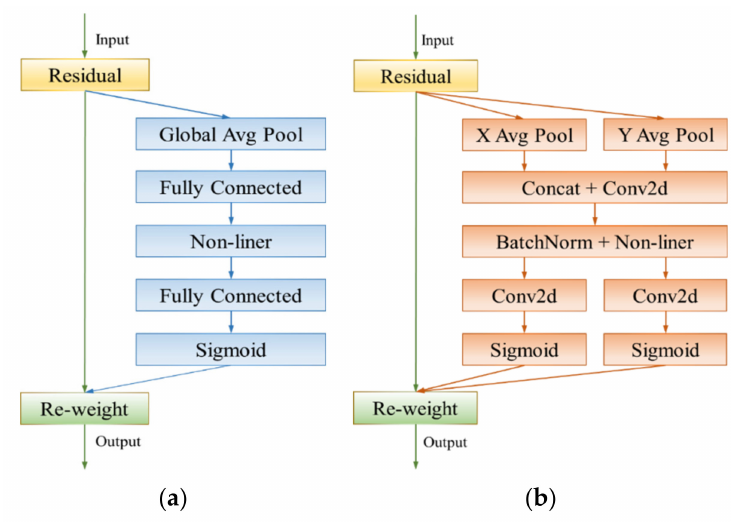
Figure 6. Comparison of the proposed coordinate attention block. ( a ) SE block. ( b ) CA